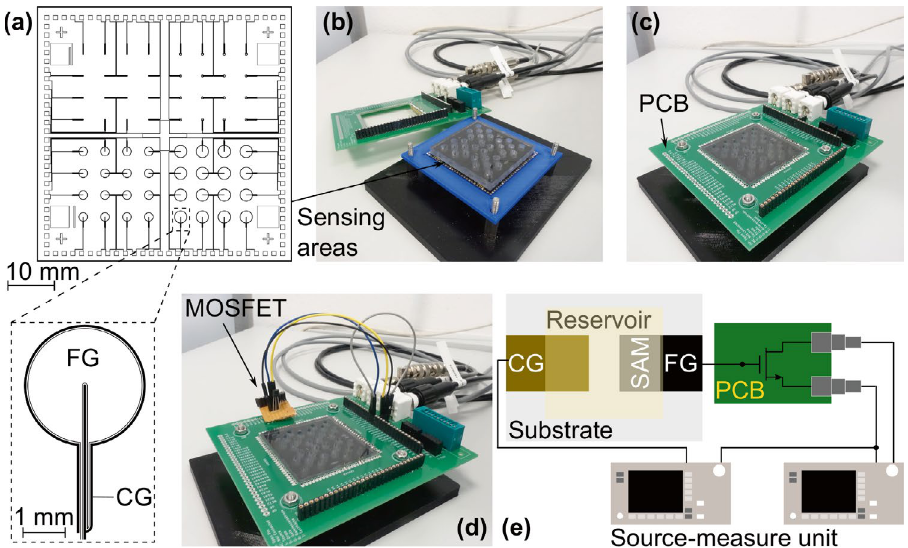
Figure 2. Hybrid setup of the developed EGFET. ( a ) Lithography mask with one sensor area displayed in larger scale underneath. For a better visualization, the area of the control-gate electrode (CG) is filled whereas the floating-gate electrode (FG) is only displayed with a framed line. All closed areas on the lithography mask are filled by a chromium layer. ( b ) Realization of the sensor thin-film substrate. The polycarbonate plate has open holes for the liquid and is stick to the glass substrate. ( c ) PCB for connection purposes between the sensor substrate, the transducer, and the SMUs. ( d ) Connection between a sensor area and the MOSFET by wire jumpers. ( e ) Integration of the SMUs into the measurement setup for recording the transfer characteristics.